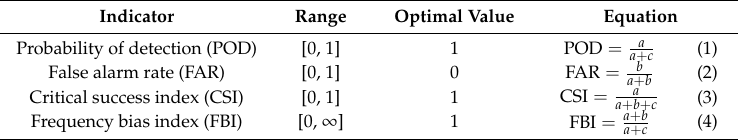
Table 3. Indicators for the analysis of precipitation detection capacity.